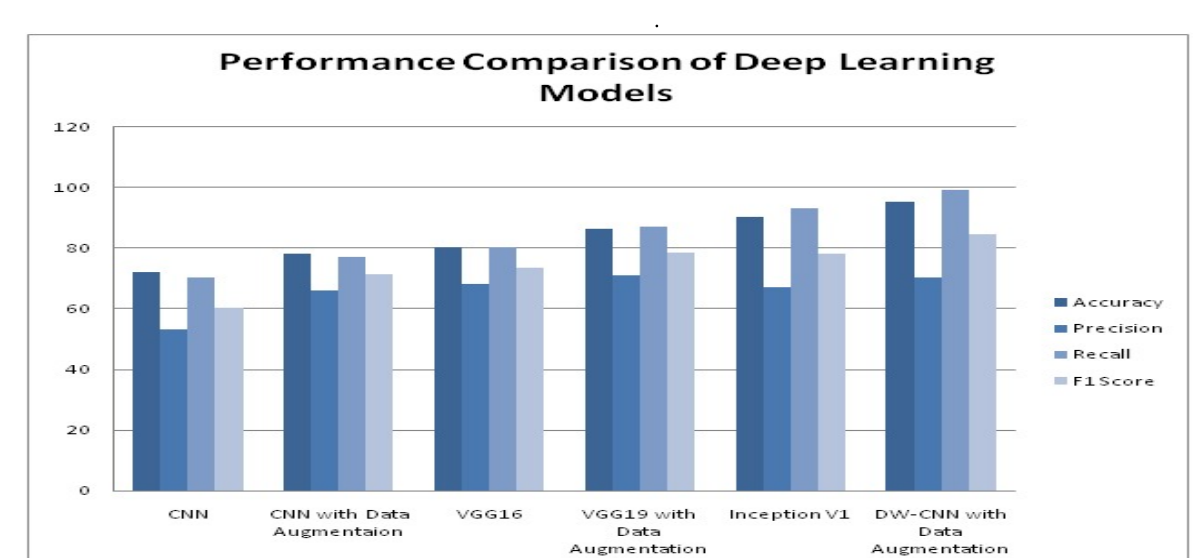
Figure 8. Performance Comparison of Deep Learning